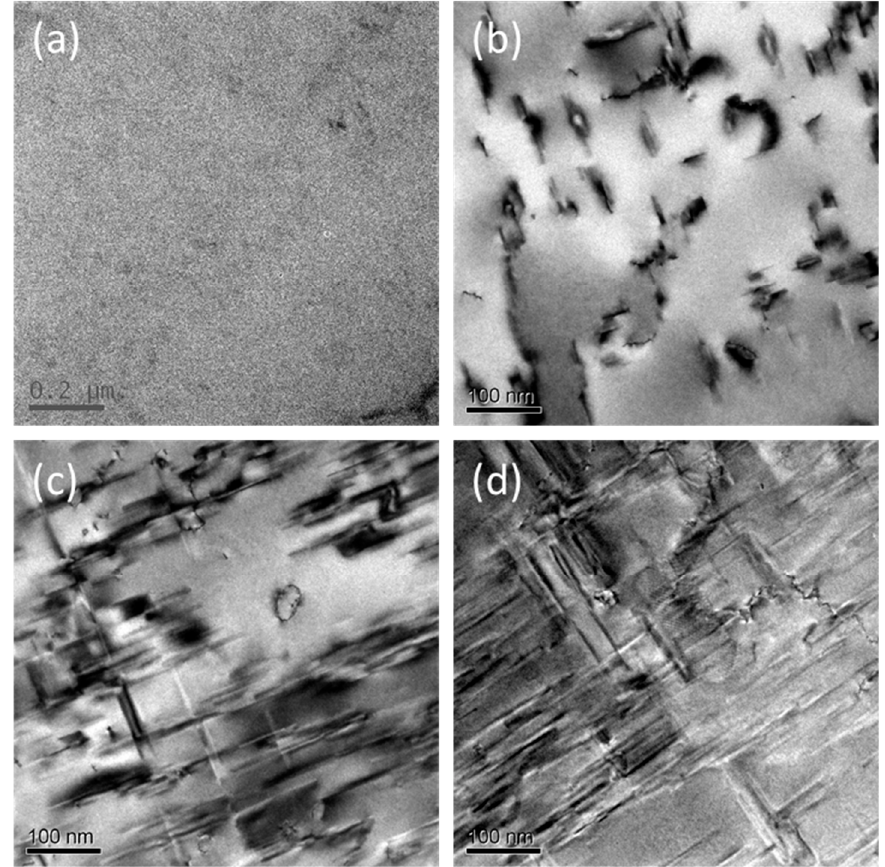
Figure 4. TEM images of intragranular microstructures of the pre-aged AA2524 alloy. ( a ) As-received material;( b ) 3 h pre-aged;( c ) 6 h pre-aged, and ( d )12 h pre-aged at 180 ° C.